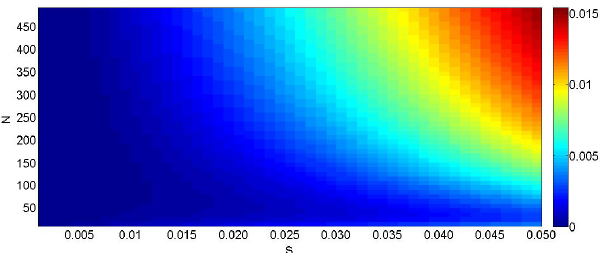
Figure 3. 2-D plot representing (cid:49)f max = f max (N,s)